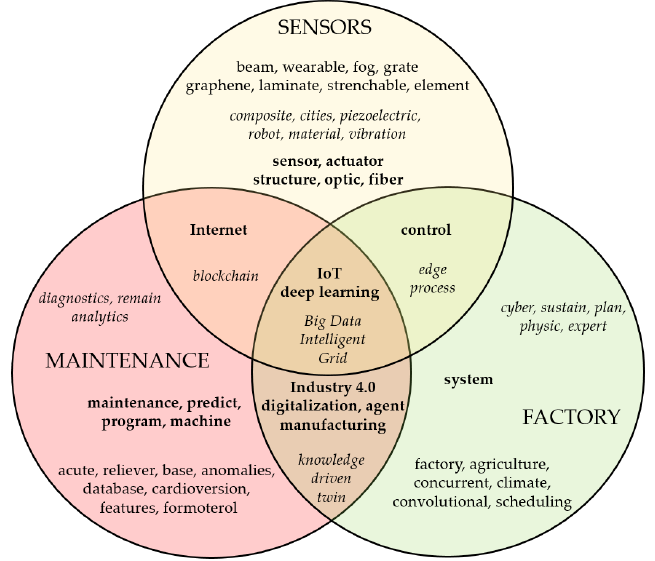
Figure 7. The top terms in analysed areas based on the burst detection. Note: The top ten used terms are highlighted “bold” and top twenty terms are depicted “italic”.